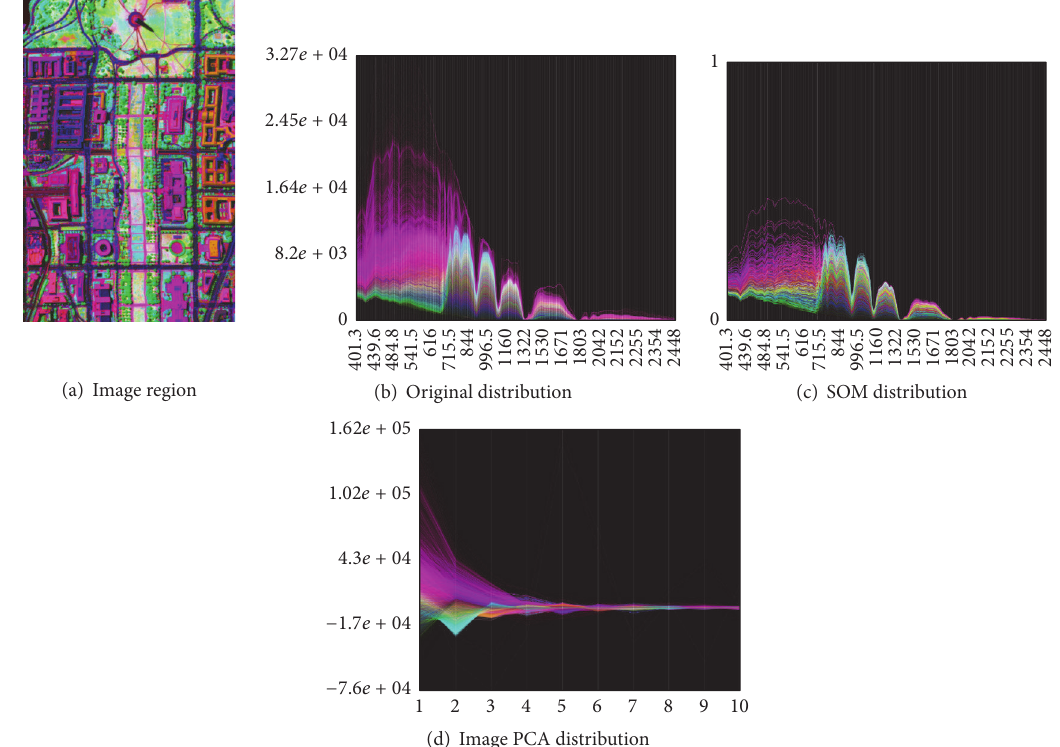
Figure 11: Center part of the D.C. Mall image and parallel coordinates visualizations computed from the data. Pixels and spectral vectors are colored using the SOM visualized in (c).